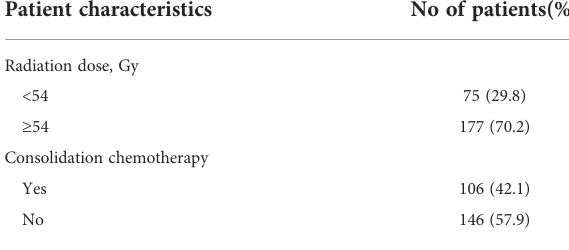
TABLE 1 Characteristics of the patients with esophageal squamous cell carcinoma treated with de fi nitive concurrent chemoradiotherapy (n =